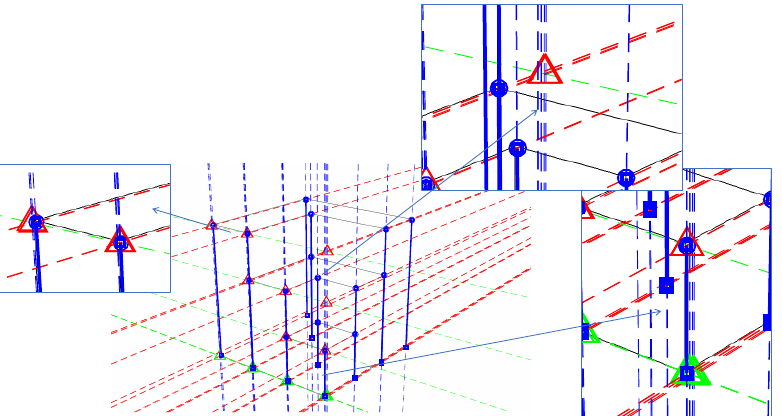
Figure 9. Base point estimation errors in each of the projection steps. The proposed vanishing point refinement process is designed to reduce the misalignment.